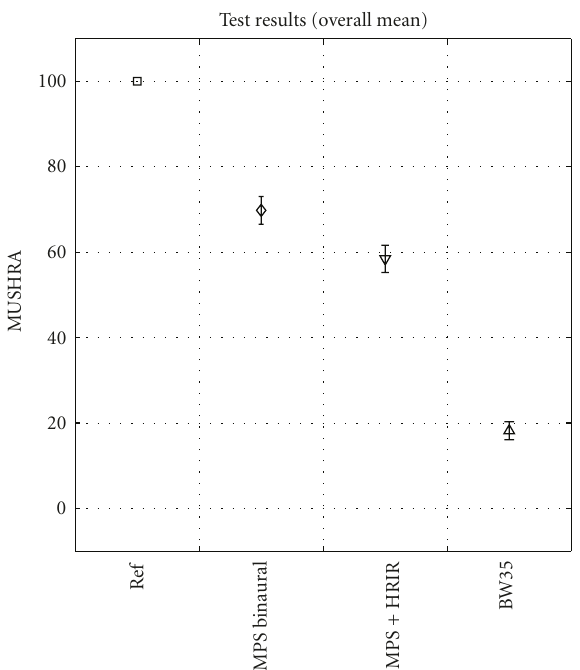
Figure 8: Overall mean scores (across subjects and excerpts) for the parametric